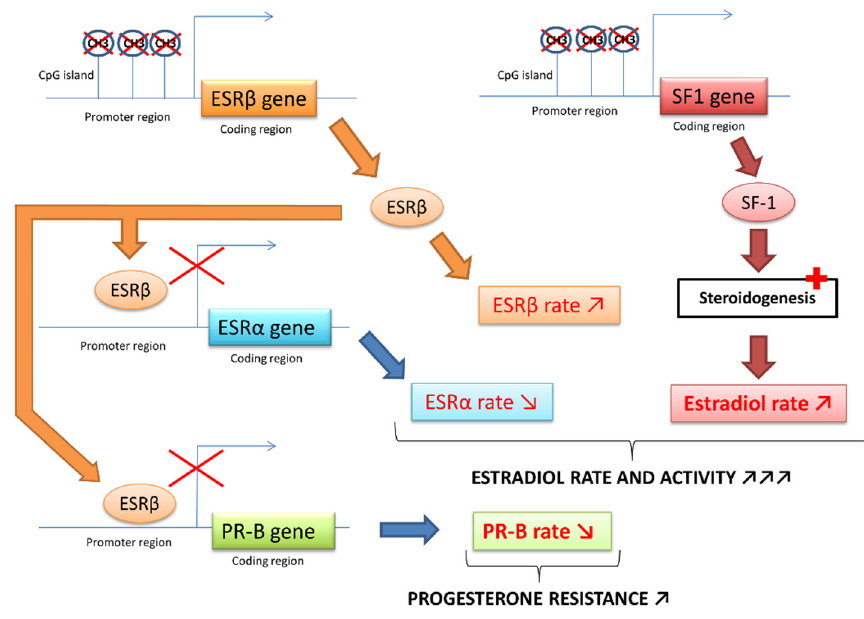
Figure 4. ESR and SF-1 receptors epigenetic modifications in endometriosis [4,22,23].